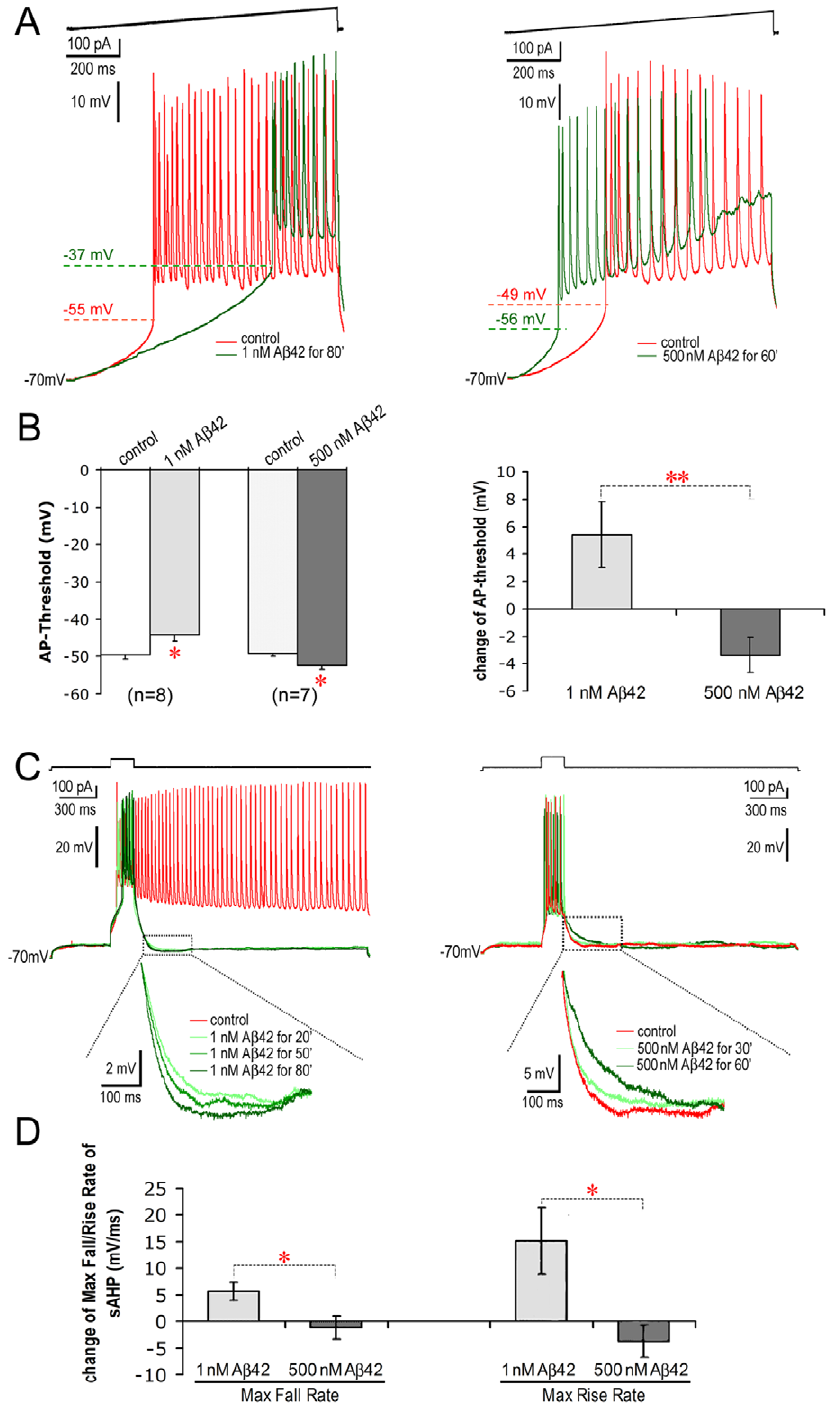
Figure 7. Opposing effects on AP-threshold and AHP by prolonged applications of low vs. high doses of A b 42. A. AP-threshold. Under calcium-free conditions, AP-threshold of a neuron was recorded during injection of a ramp-current (above the AP traces) into the soma. After 1 nM A b 42 was applied for 80 min. the AP-threshold of a PC increased from 2 55 mV to 2 37 mV (left panel). After 500 nM A b 42 applications for 60 min. the AP- threshold of another PC was reduced from 2 49 mV to 2 56 mV (right panel). B. Statistical comparison of changes in AP-threshold. Left Panel: After applications of 1 nM A b 42 for $ 30 min., the AP-threshold was significantly increased ( p =0.047, n =8). After applications of 500 nM A b 42 for $ 30 min., the AP-threshold was significantly reduced ( p= 0.029, n =7). Right Panel: Opposing net changes (i.e., A b –control) in AP-threshold between 1 nM and 500 nM A b 42 treatments ( p =0.006). C. AHP. Left Panel: After a burst induced by a depolarizing current injection for 200 ms, a tonic firing was extended in a PC. This tonic firing was attenuated by the application of 1 nM A b 42 (green traces). Moreover, the AHP of the PC gradually deepened over time (left panel, inset). Right Panel: Under high dose A b 42 exposure (500 nM), the AHP of another PC became gradually shallower over time (right panel, inset). This increase in excitability can result in tonic firing in some neurons (see figure S3). D. Statistical comparison of net changes in AHP. Compared with control, 1 nM A b 42 deepened the AHP by speeding up its net maximum fall and rise rates. In contrast, 500 nM A b 42 slowed down maximum fall and rise rates (net change in the Max Fall Rate: p =0.021; net change in the Max Rise Rate: p =0.025). Note: ‘‘*’’, p , 0.05; ‘‘**’’, p , 0.01.